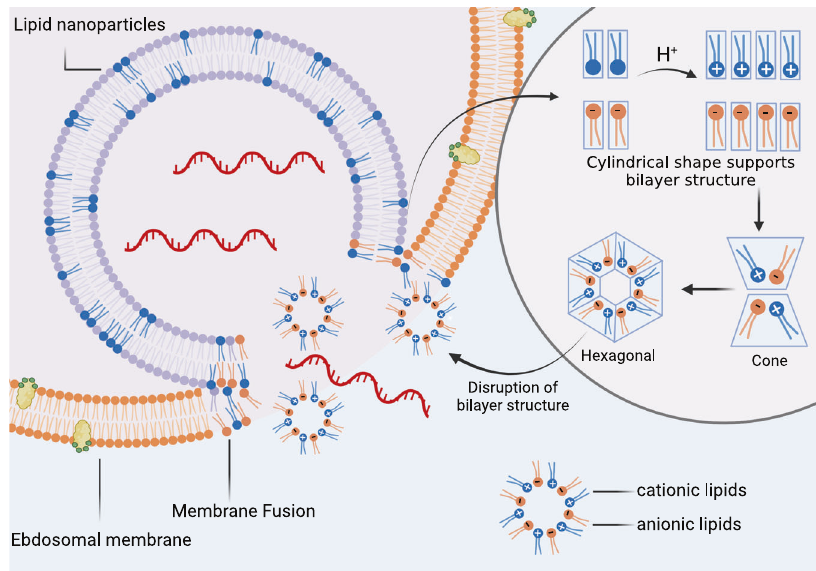
ionizable lipids in lipid nanoparticles (LNPs) and anionic lipids in the endosomal membrane adopt a cylindrical conformation which is compatible with molecular packing in a bilayer phase. The acidic environment in endosomes facilitates protonation of